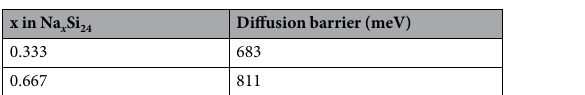
Table 1. Computed diffusion barriers for Na migration using CI-NEB